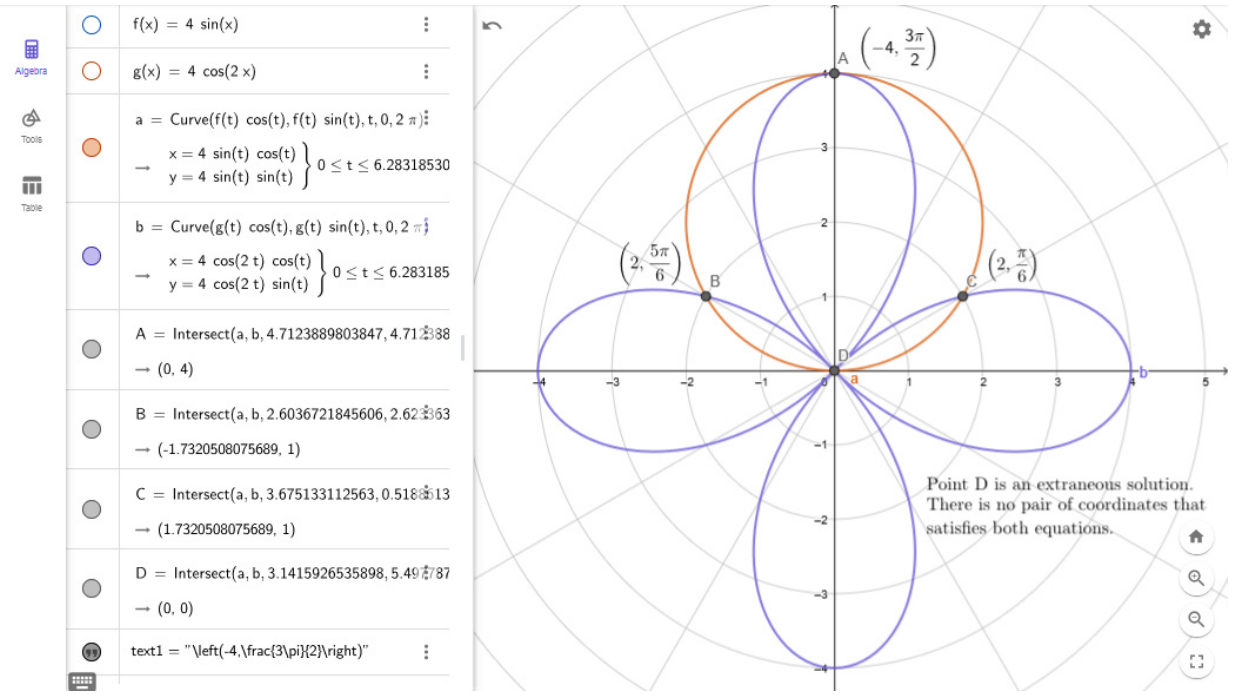
Figure 3. Finding the points of intersection of the graphs of two polar equations. The graphs can be easily obtained and the intersection points easily found, although it is necessary to algebraically verify the solutions found.